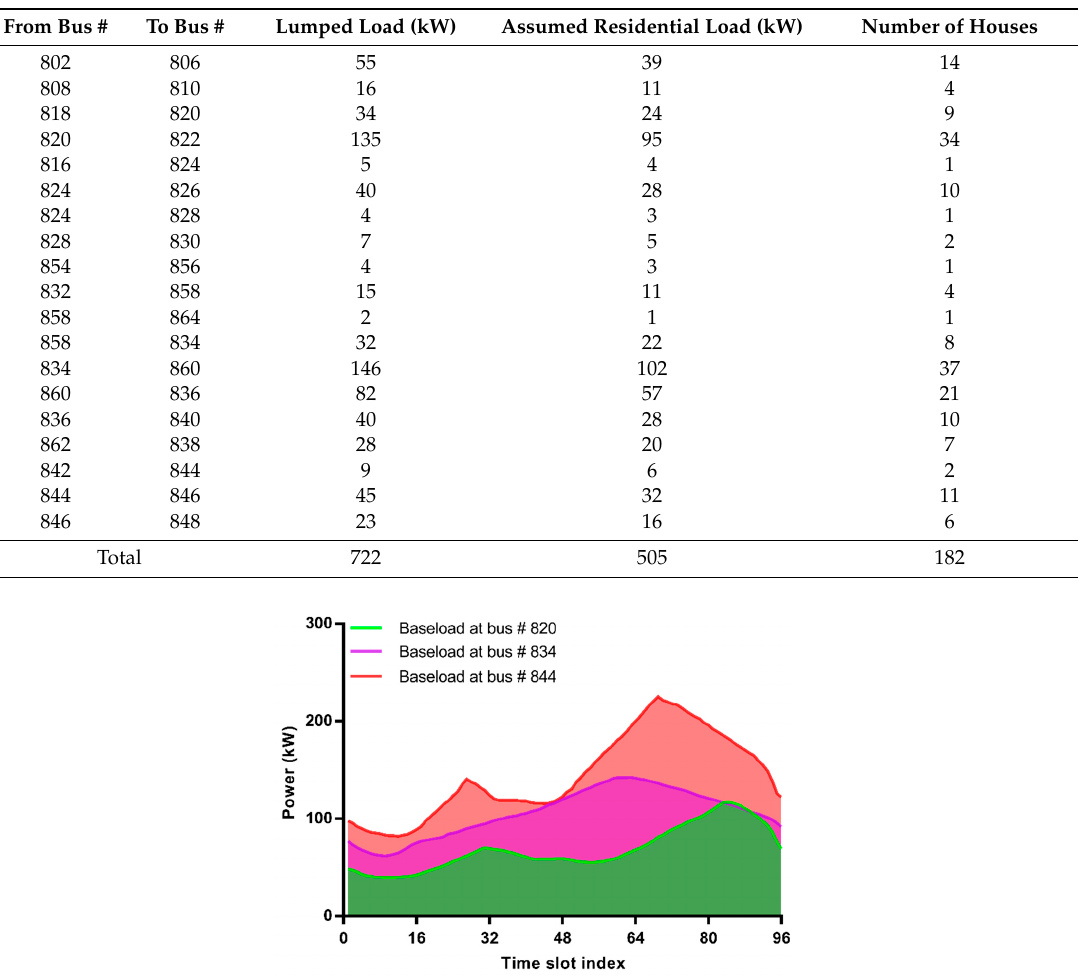
Figure 8. Residential baseload profile of three buses number 820, 834 and 844.